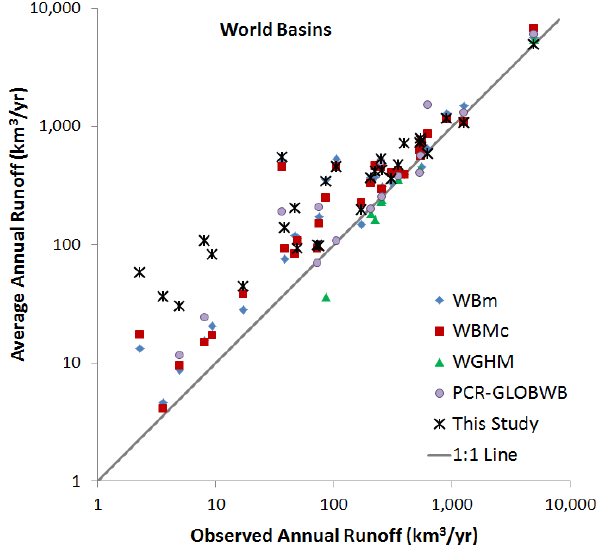
Figure 3. Comparing simulated runoff for the major basins of the Figure 3: Comparing simulated runoff for the major basins of the world against observed values world against observed values (from (from GRDC)